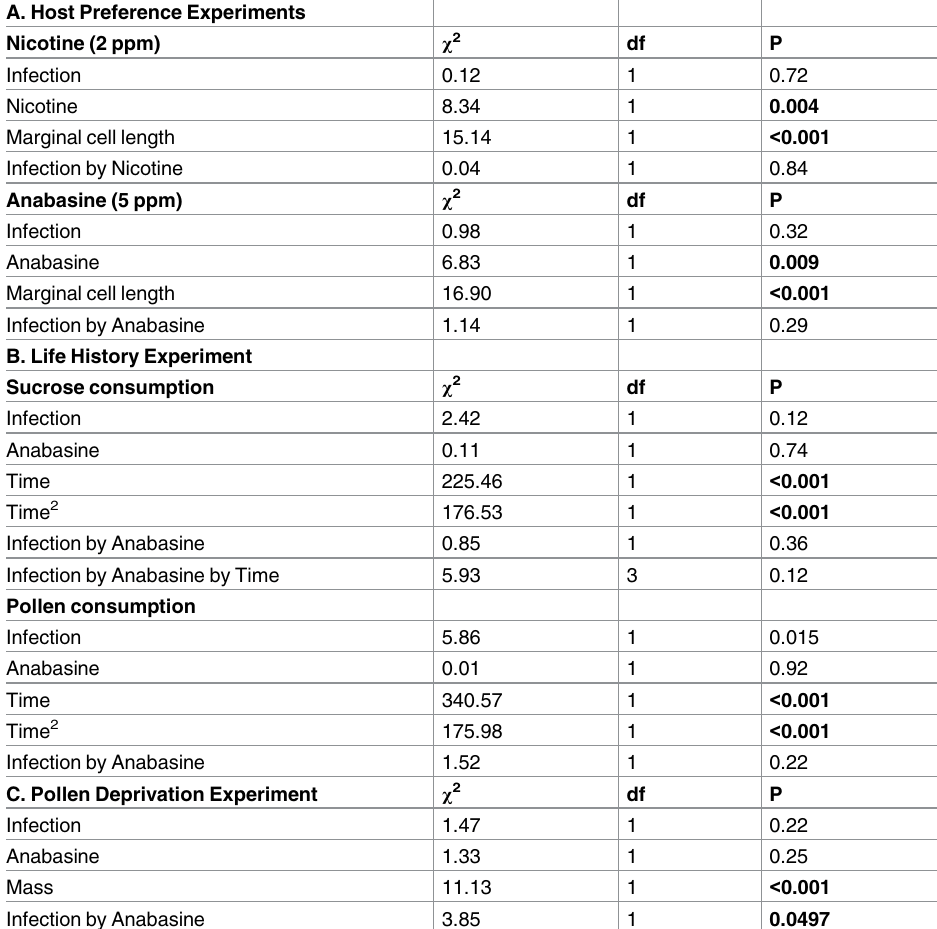
Table 2. Effects of Crithidia infection and 5 ppm anabasine on consumption of sucrose solution and pollen in choice and no-choice experiments. (A) In Host PreferenceExperiments, individualbees were givena choicebetween30% sucrosesolutionwith and without5 ppm anabasine. The 24 h trial was conducted 7 d post-infection. (B) Consumption in microcolonies of Life History Experiment and (C) of individualbees in PollenDeprivation Experiment under no-choiceconditions. Consumptionwas measuredover the entire experiment (up to 35 d for Life History Experiment,7 d for PollenDeprivation Experiment). Time was not a sig- nificant predictor of consumption in the PollenDeprivation